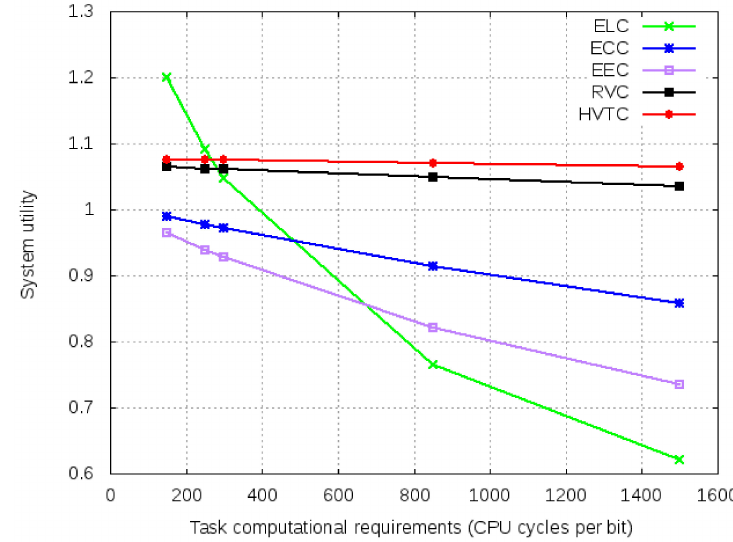
Figure 13. System utility for varied task computational